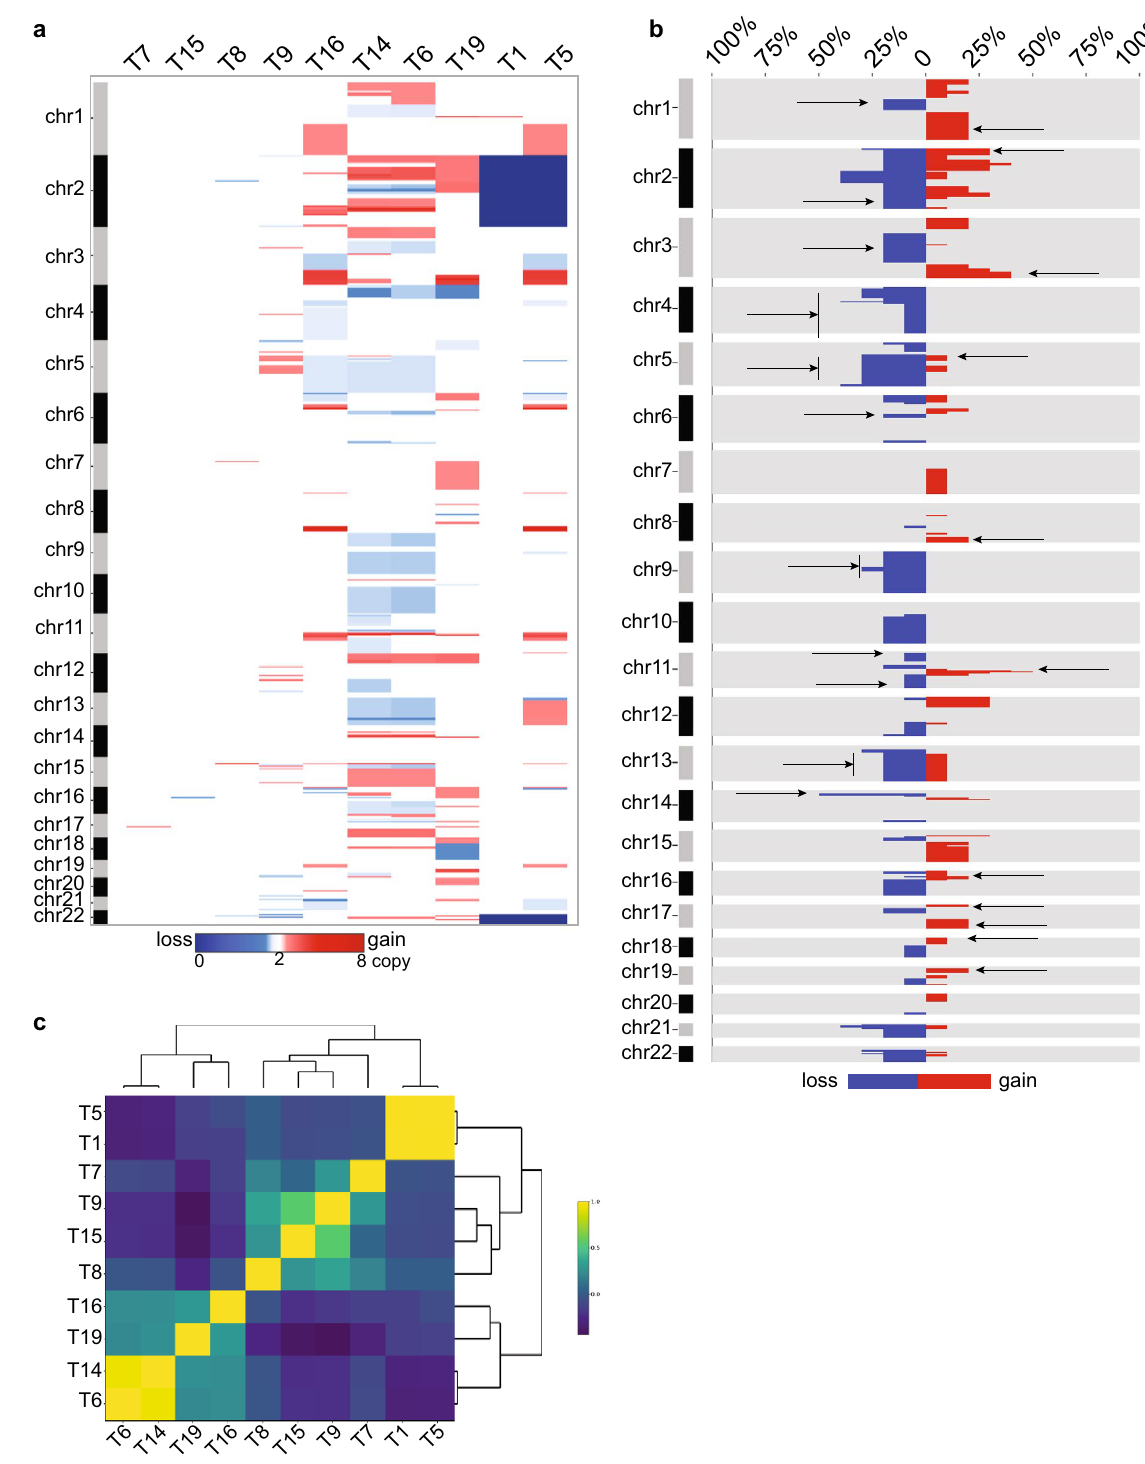
Figure 3. SCNAs in AA ESCC genomic regions encode cancer-related genes. ( a ) SCNA region profiles by 1 MB were visualized using CNApp. Dark blue represents homozygous deletion (copy number 0), white represents diploid (copy number 2), red represents copy number gains (the darkest red is copy number 8). ( b ) SCNA region frequency plot shows the percentage of samples with gains (red), losses (blue), and no alteration (gray) across chromosomes. Arrows represent the regions that also found in the 17 AA ESCC cohort analysis. ( c ) Plot shows the hierarchical clustering for samples correlation by Pearson correlation. Pearson r correlation coefficient r = 1 is yellow, r = − 1 dark navy